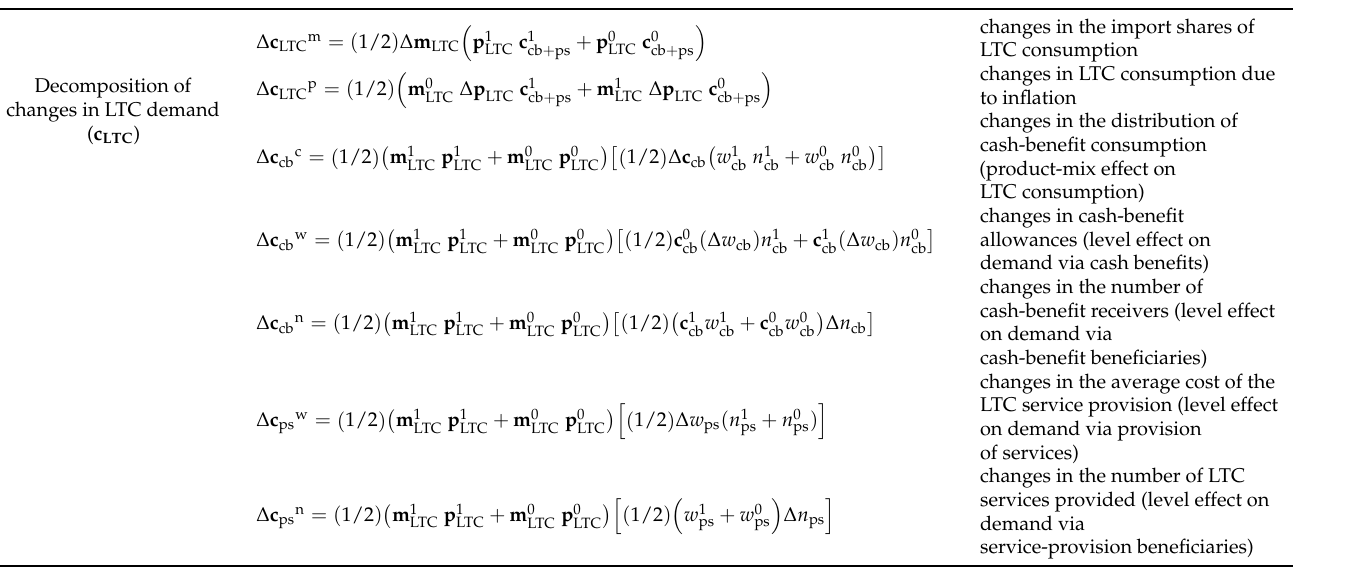
Table A2. Definition of components involving the SDA of changes in LTC demand ( c LTC